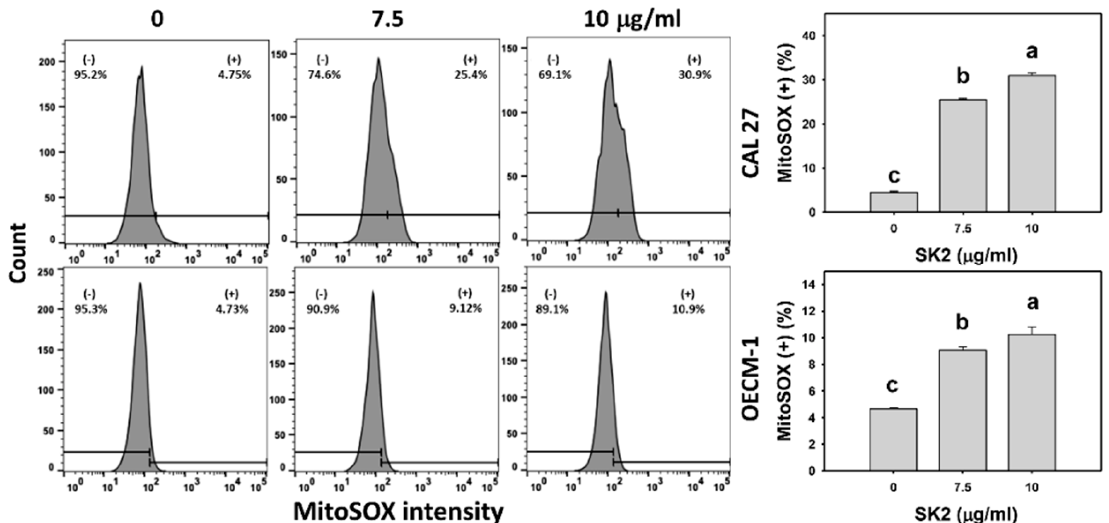
Cells were exposed to SK2 (0 (0.1% DMSO), 7.5, and 10 µg/mL) for 24 h. (+) in each panel represents ROS (+). Data (means ± SDs; n = 3) without overlapping characters differed significantly ( p < 0.05). For an example of CAL 27 and OECM-1 cells, different concentrations with different characters produced significantly different results. For CAL 27 and OECM-1 cells, for SK2 at 0, 7.5, and 10 µg/mL, “c, b, and a” indicate significant differences because the data did not overlap.